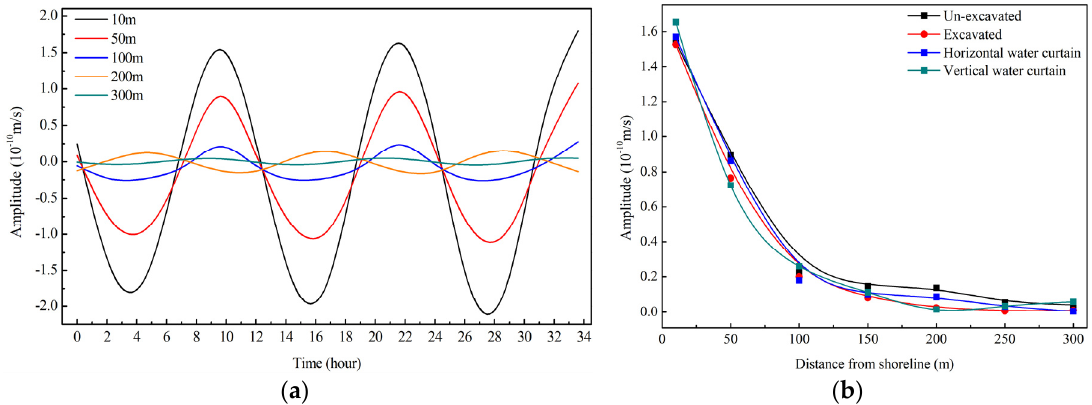
Figure 10. Seepage velocity fluctuation amplitude: ( a ) different distance from shoreline under excavated condition; ( b ) fluctuation amplitude damping.